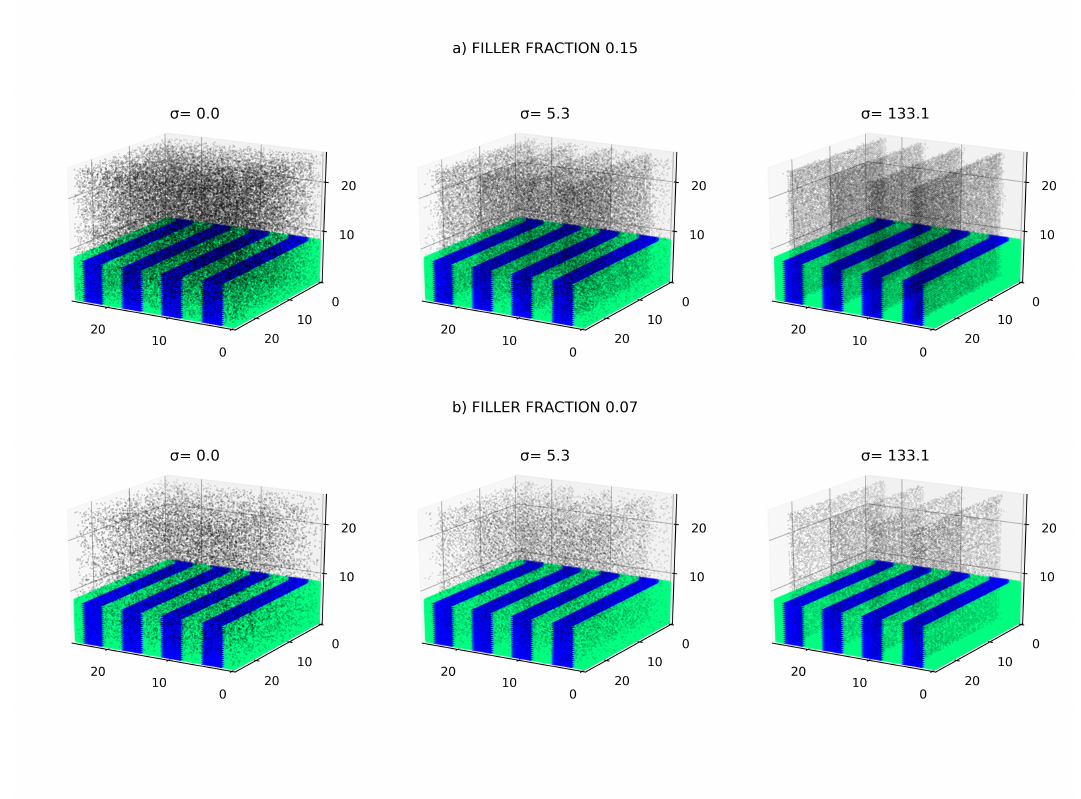
Figure 1. Effect of the contrast between the affinities of fillers for dissimilar copolymer blocks on the dictribution of these fillers in the microphase-separated DBC system: ( a ) larger filler volume fraction φ = 0.15; ( b ) smaller filler volume fraction φ = 0.07. Black dots show the centers of the filler particles. The upper part of the image of the host DBC matrix is cut off to make visible the distribution of fillers inside the DBC system. Selective A phase having larger affinity for polymers is shown in blue, B phase in green. All lengths are measured in R G